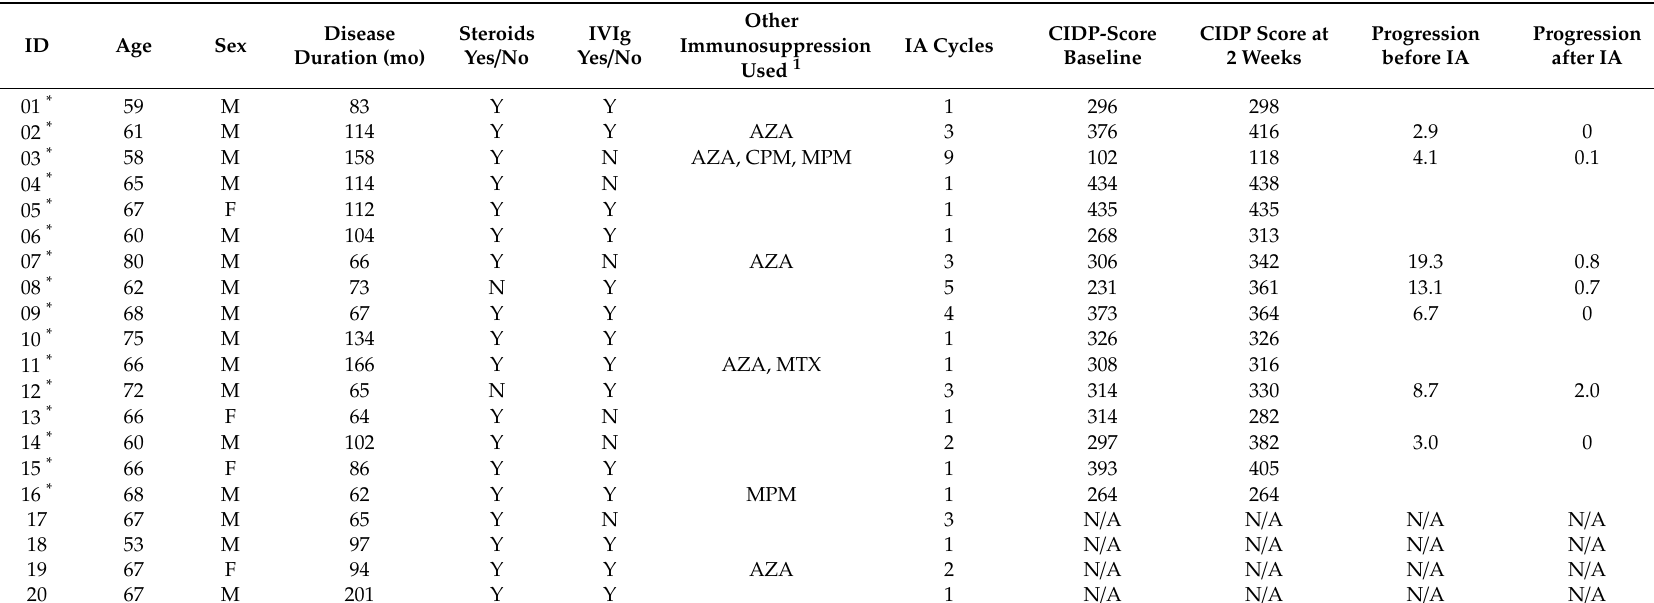
Table A1. Baseline characteristics and response to IA treatment of the CIDP